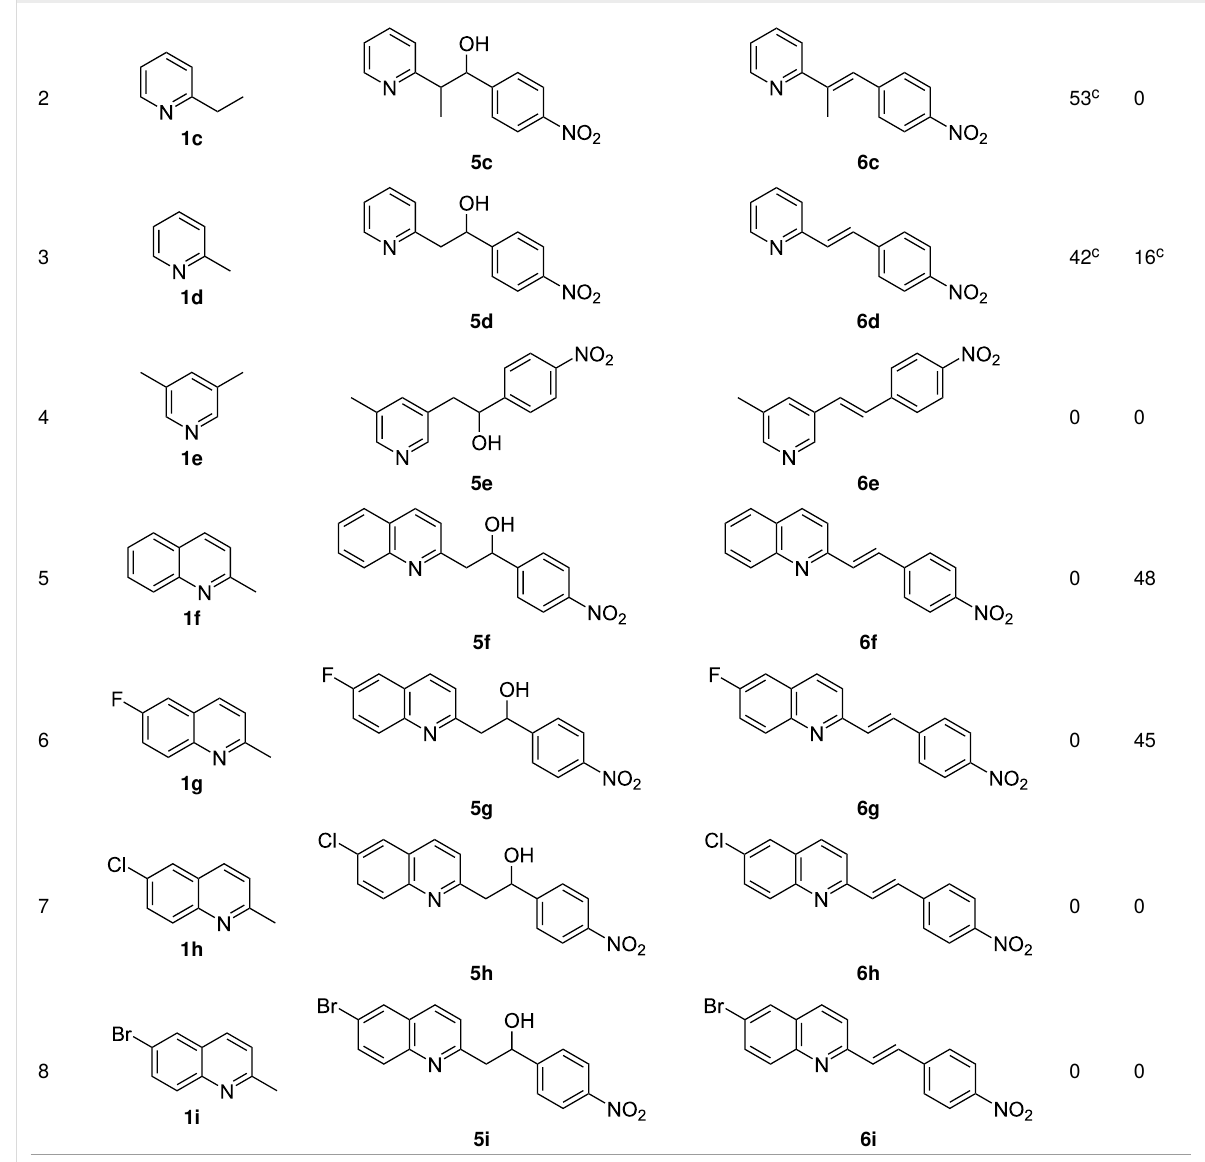
Table 3: Variation of the azaarene component 1 . a